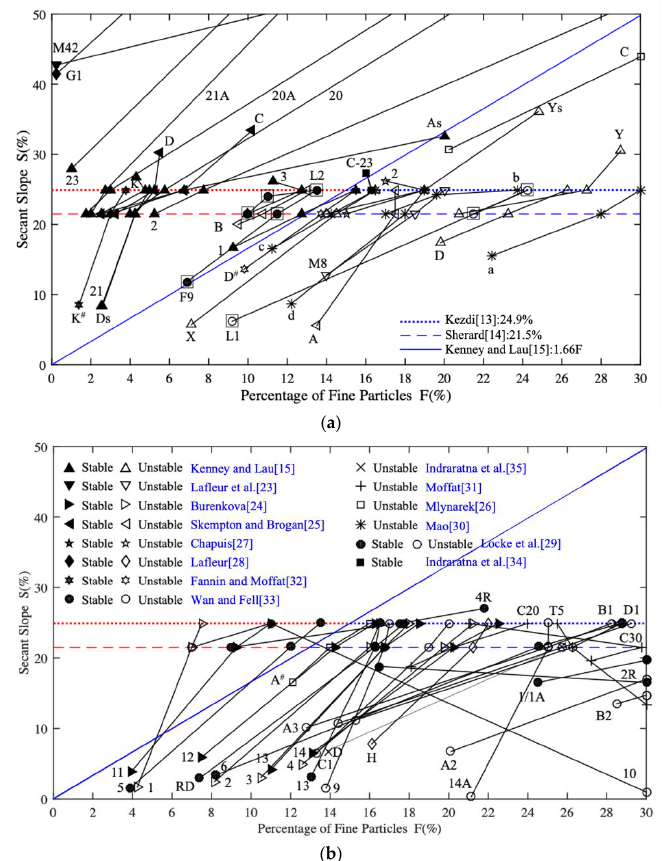
Figure 3. Connection lines of the studied soil specimens. ( a ) Connection lines of sand – gravel soil specimens. ( b ) Connection lines of (clay) – silt – sand – gravel soil specimens.